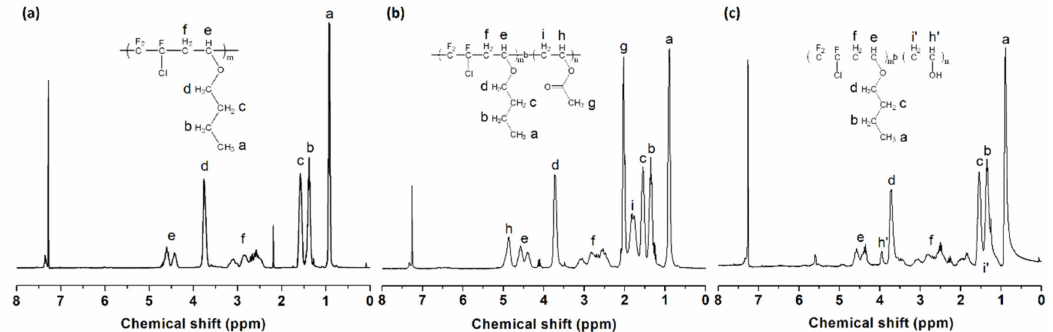
Figure 3. 1 H NMR spectra of ( a ) poly(CTFE-alt-BVE) (Sample P4), ( b ) poly(CTFE-alt-BVE)- b -PVAc, and ( c ) poly(CTFE-alt-BVE)- b -PVA.